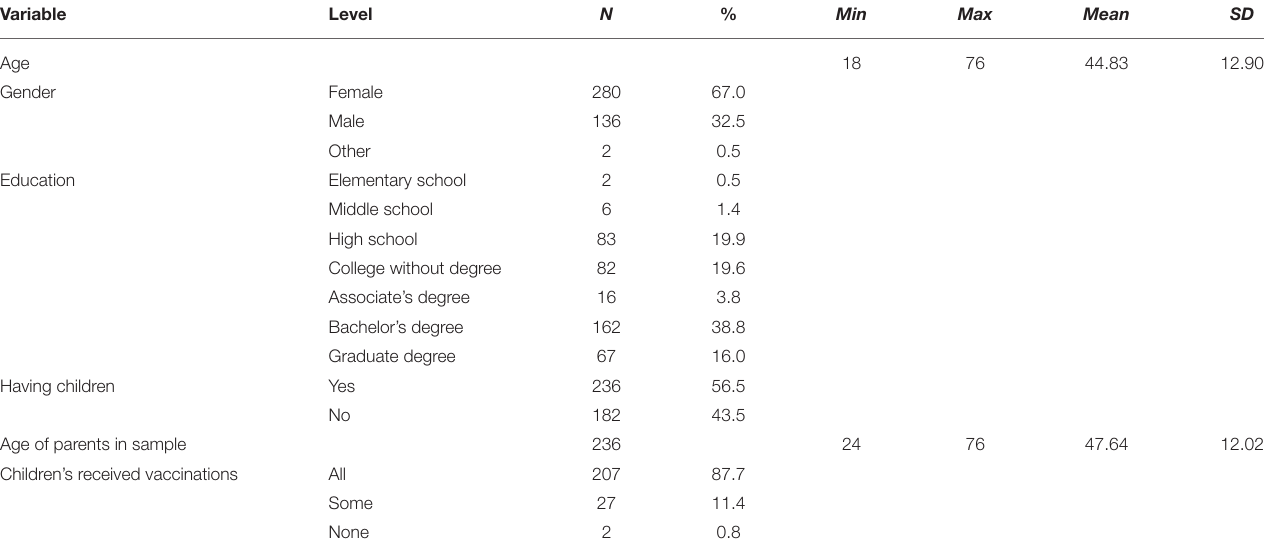
TABLE 1 | Participant characteristics in experiment